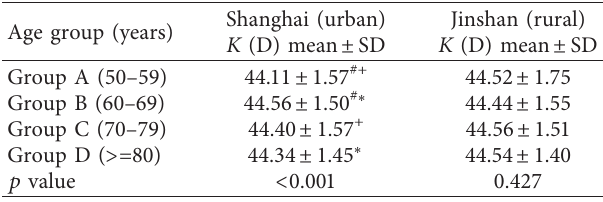
Figure 2: Distribution of ACD in Shanghai and Jinshan pop- ulations in all age groups. Table 3: Descriptive statistics of mean K reading in 4 age